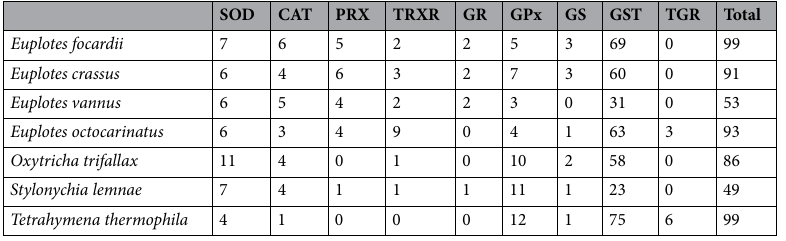
Table 6. Number of antioxidant enzymes predicted in ciliate organisms phylogenetically close to E. focardii . These values were obtained consulting the annotated proteins